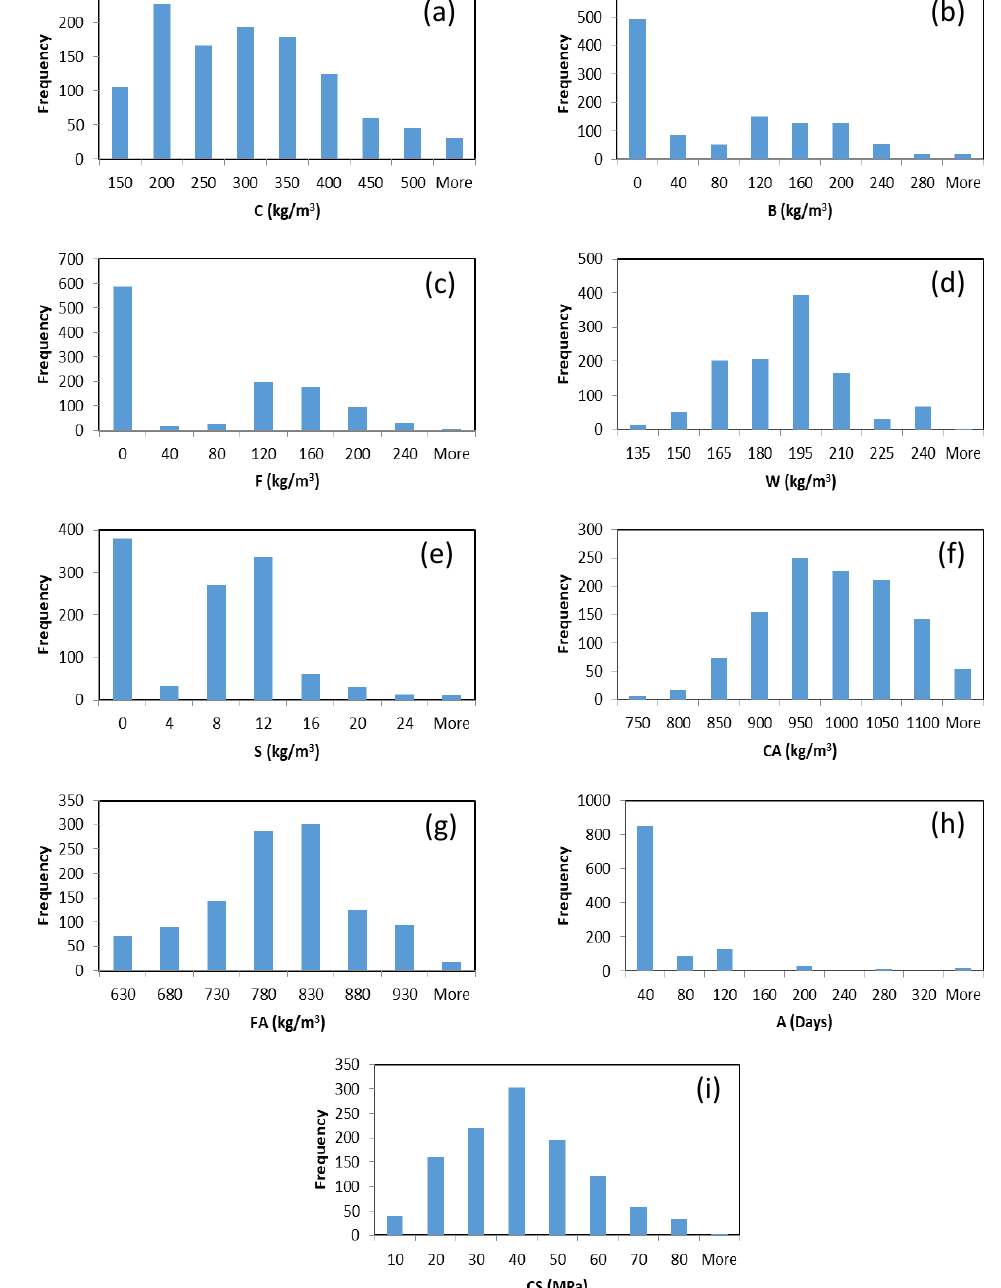
Figure 1. Histograms of the dataset